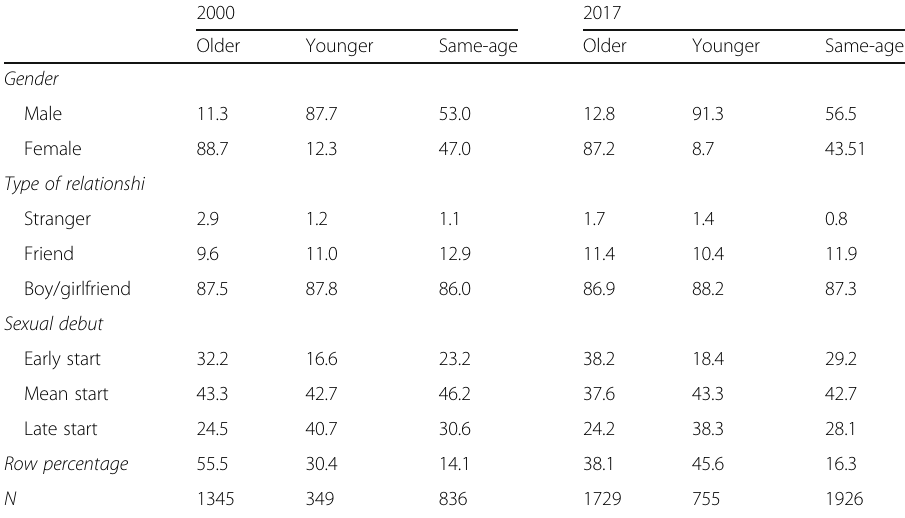
Table 6 General descriptive statistics of first set of models (column percentages of key determinants for both SELFY waves) 2000 2017